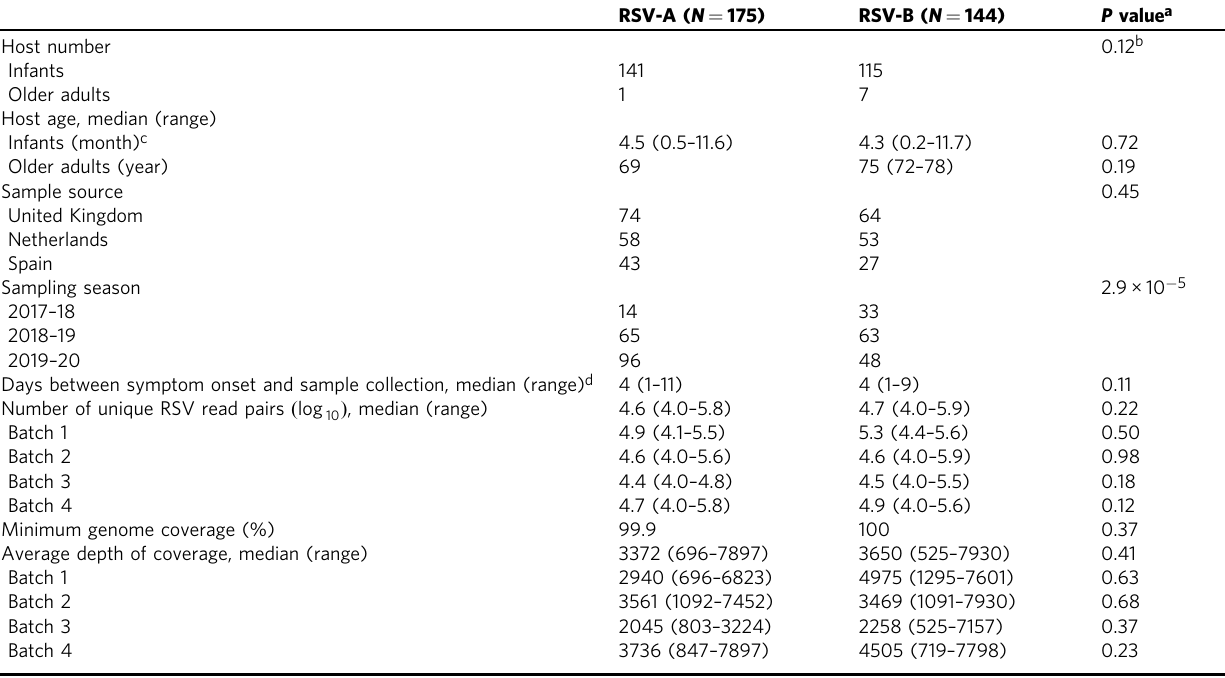
Table 1 Characteristics of RSV samples by